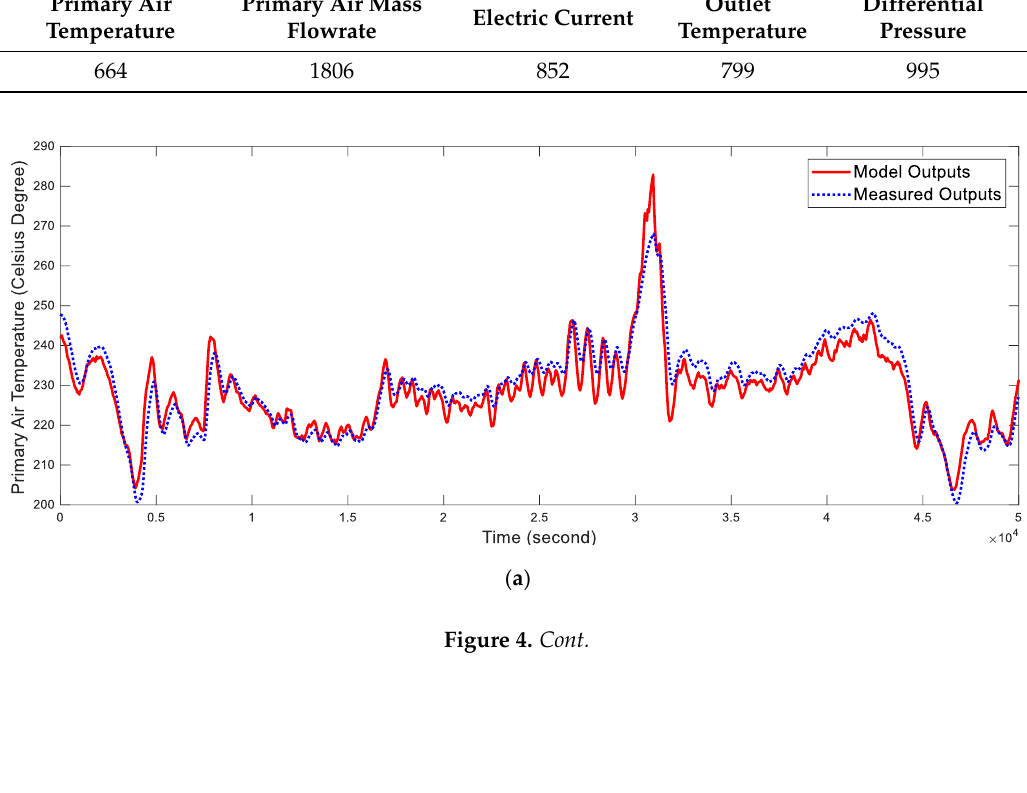
Table 3. Cumulative relative fitting error.